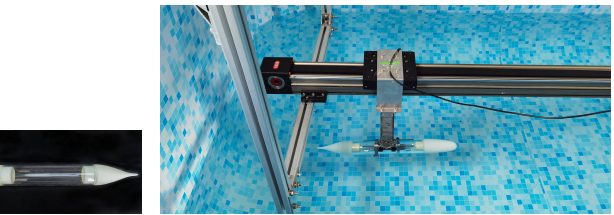
Figure 27. SUBOFF model and its towing experiment setup in our physical experiment platform.